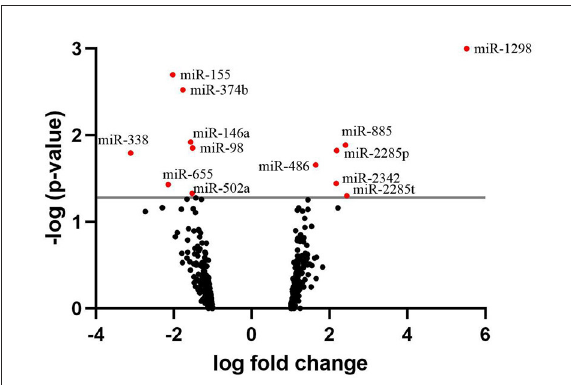
FIGURE4 Validation of the mRNA-seq and miRNA-seq differentially expressed genes by RT-qPCR. Both miRNAs, miR-100 and miR-34c exhibited the same trend (an upregulation in the high fertility group) for RNA-seq and RT-qPCR. For four out of the five differentially expressed genes identified by mRNA-seq and assessed by RT-qPCR, the same trend was observed i.e., a downregulation of PRM1 , SCP2D1 and ENSBTAG00000048468 as well as an upregulation for RBBP6 . ENSBTAG00000054826 did not observe the same